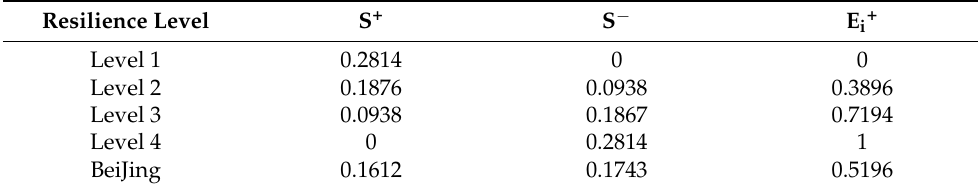
Table 16. Urban stormwater resilience grade